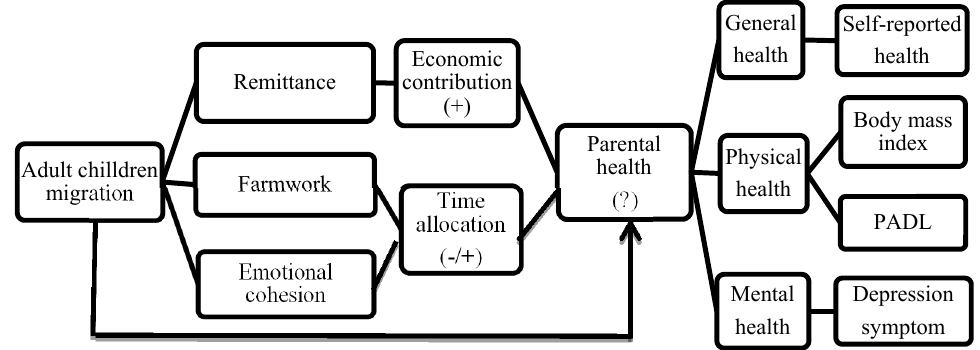
Figure 1. Conceptual framework for the impact of the child migration on parental health in rural areas. Notes: (1) A minus (resp. plus) sign indicates a negative (resp. positive) impact on the parental health; (2) PADL stands for physical activity of daily living.